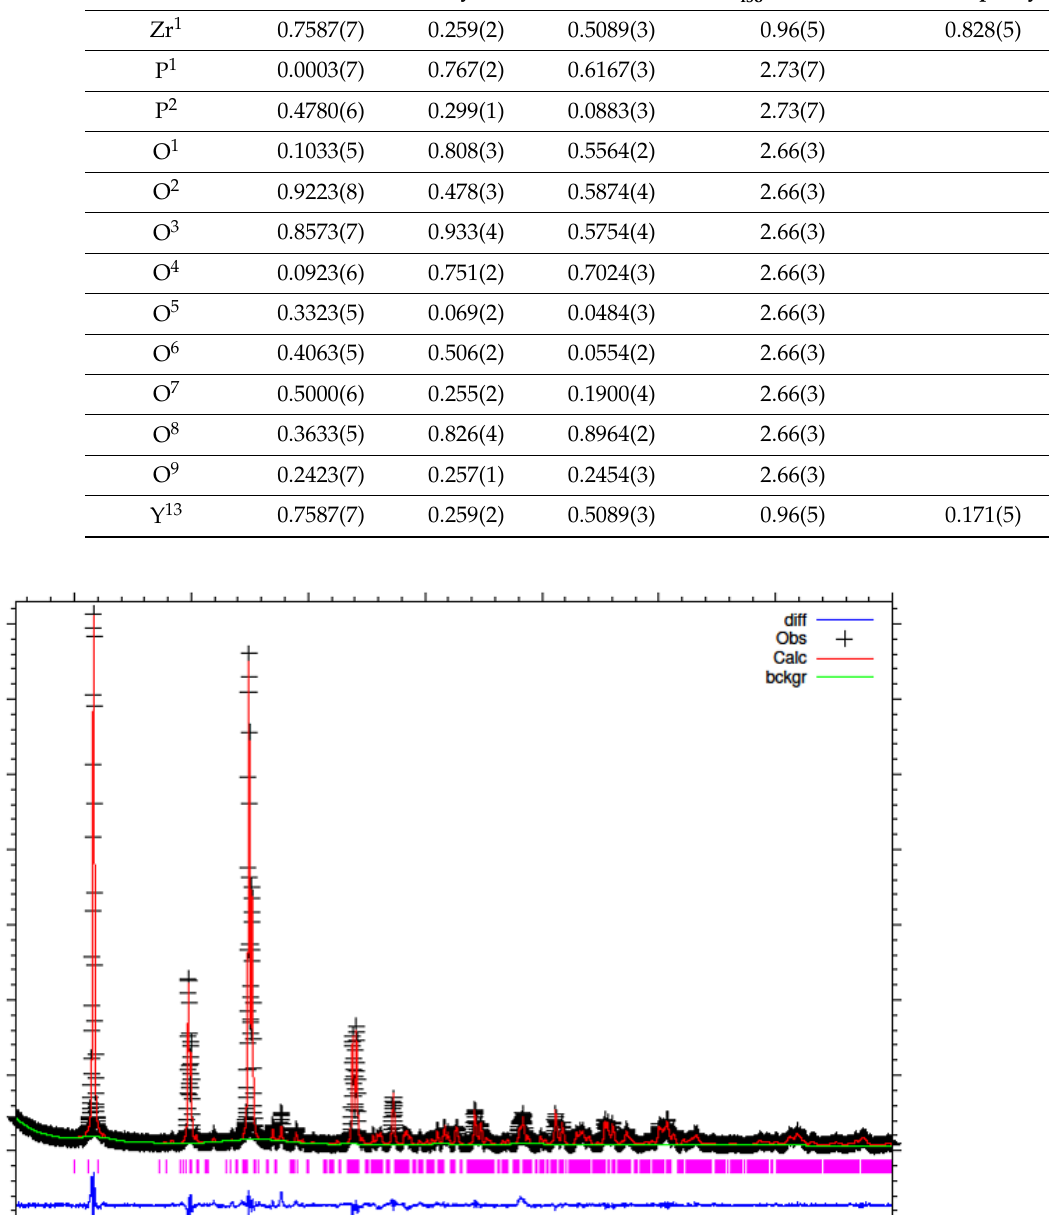
Table 9. Refined fractional atomic coordinates and isotropic thermal displacement parameters for hydrothermally synthesised 15% Y-ZrP. Table 3. Refined fractional atomic coordinates and isotropic thermal displacement parameters for conventionally refluxed 5% Y–ZrP.